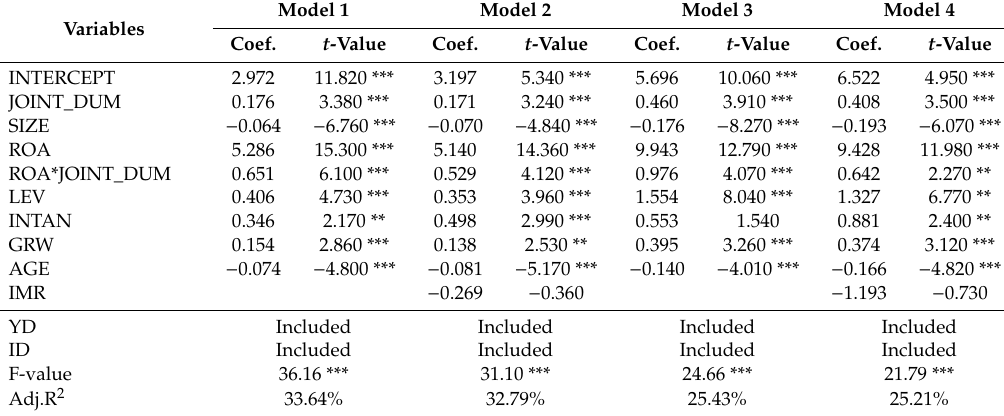
Table 14. The e ff ect of Profitability and Analysts’ cash flow forecasts issuance on firm value. Variables